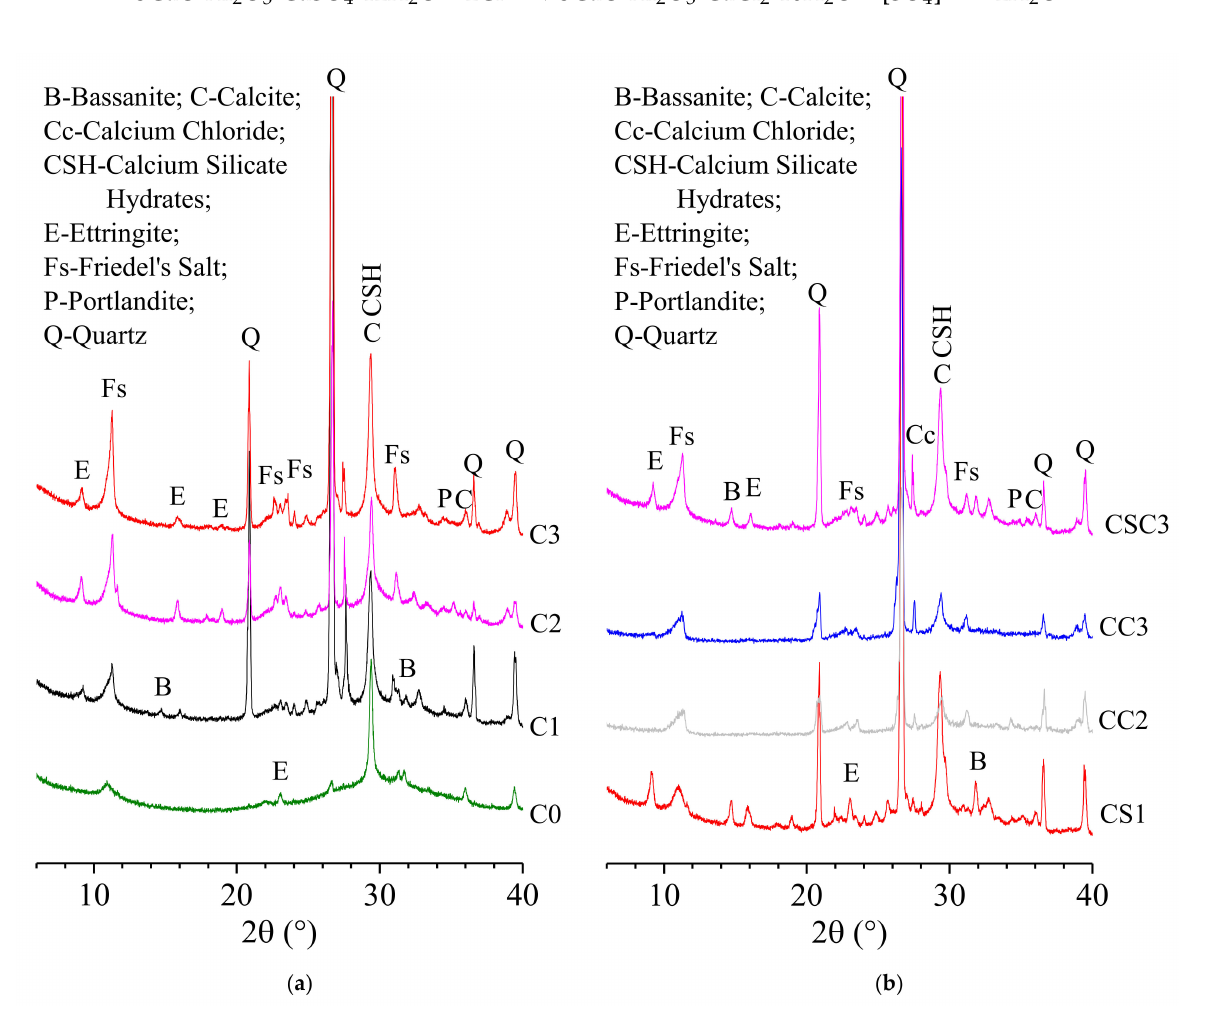
Figure 5. XRD patterns of ( a ) C0, C1, C2, and C3 at 28 d; ( b ) CS1, CC2, CC3, and CSC3 at 28